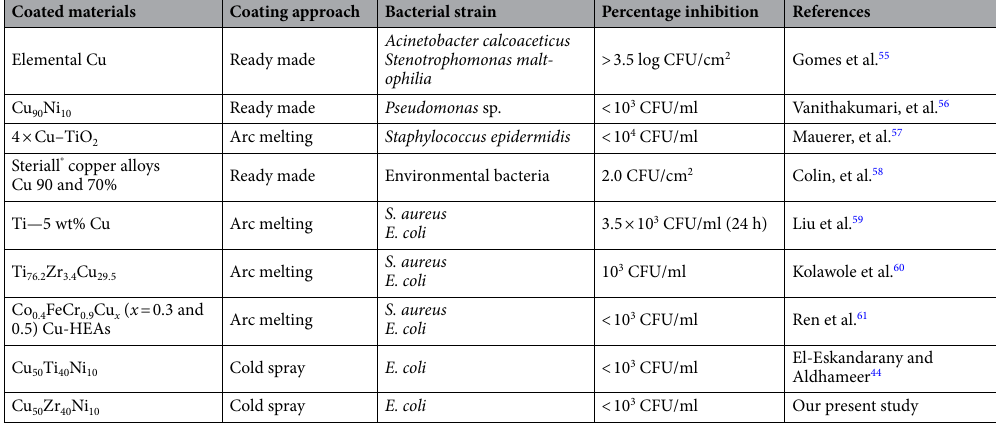
Table 3. Some researches from earlier studies presented several antibiofilm technologies that use distinct coating